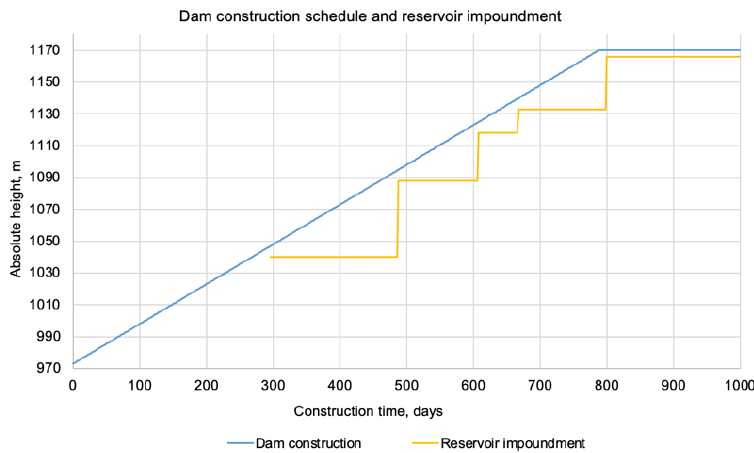
Figure 11. History of dam construction and reservoir impoundment schedule.